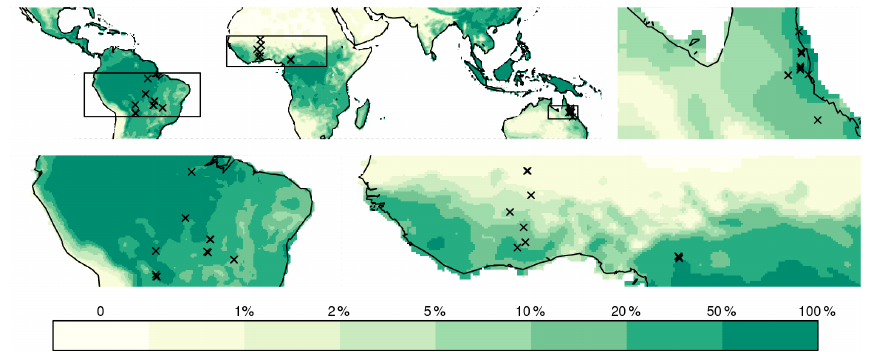
Figure 1. Location of sampling sites in Africa, Australia, and South America from the TROBIT project (based on Fig. 2 of Torello-Raventos et al., 2013) shown in MODIS VCF (DiMiceli, 2017). Of the 63 field sites, only the 48 sites with available GPS coordinates were selected (https://www.forestplots.net).